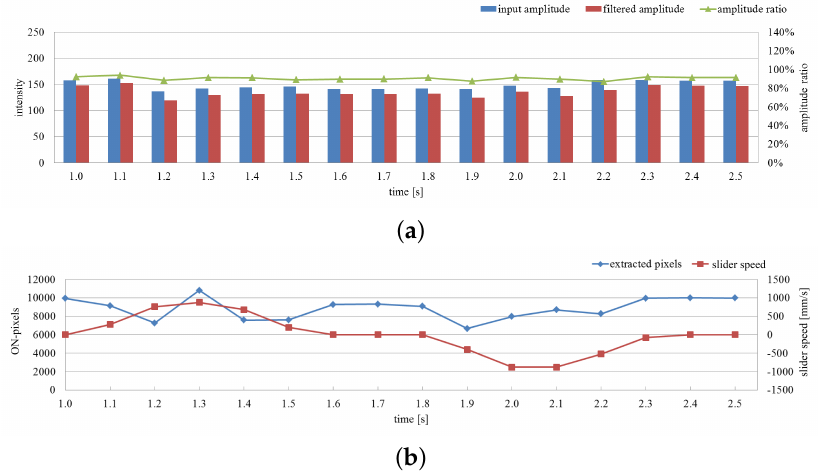
Figure 18. Averaged amplitude values and number of extracted pixels with moving background. ( a ) Averaged amplitudes of input and pixel-wise filtered images and their ratios on the extracted pixels; ( b ) number of extracted pixels as vibration region and slider